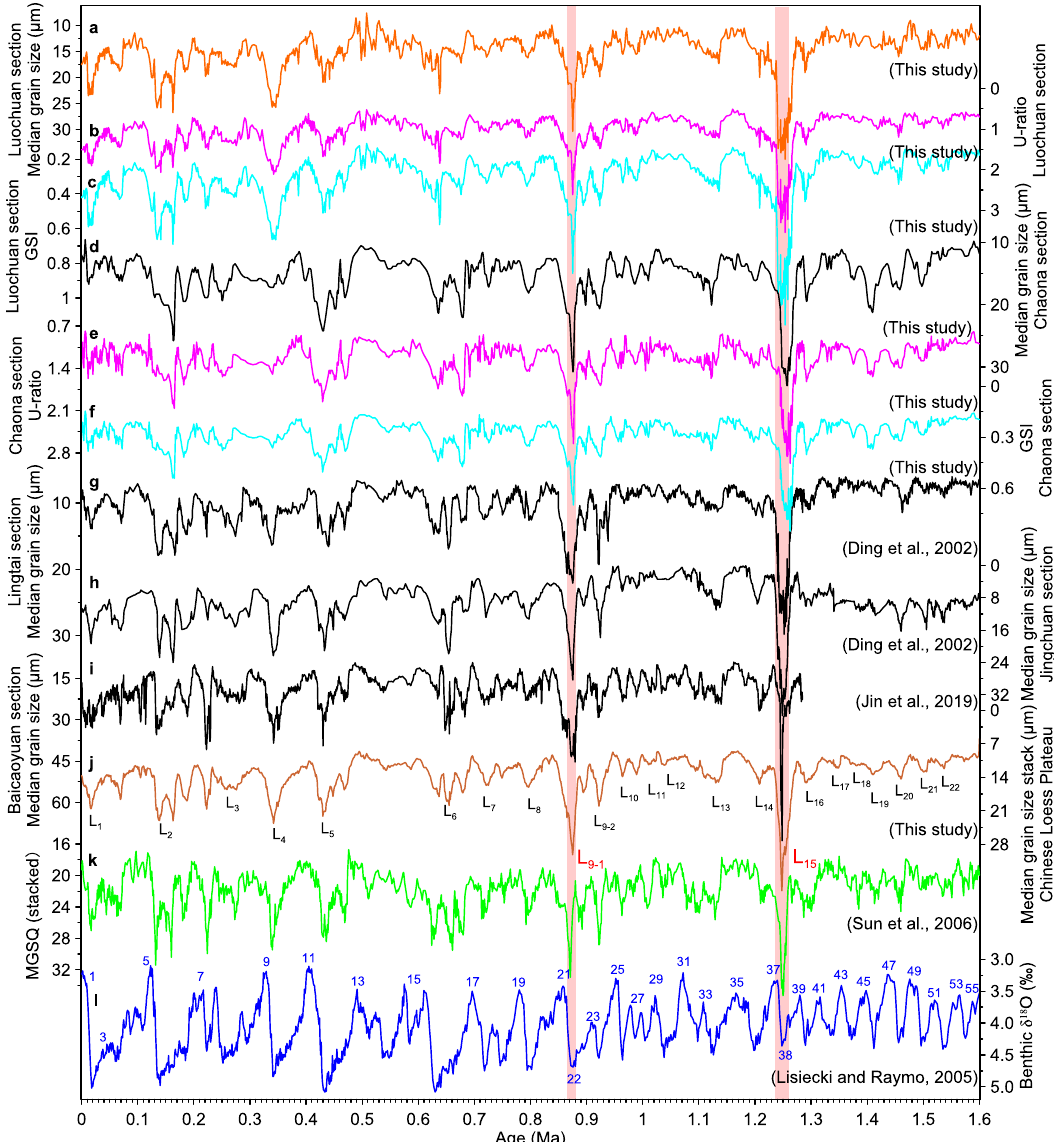
Fig. 2 Grain size variations of loess-palaeosol sequences across the Chinese Loess Plateau. Median grain size records (black lines) from the a Luochuan (this study), d Chaona (this study), g Lingtai 33 , h Jingchuan 33 , and i Baicaoyuan 44 sections on our newly re fi ned loess-palaeosol chronology. b , c